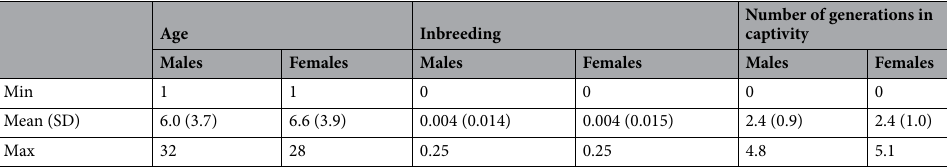
Table 1. Descriptive statistics of the three main explanatory variables used to analyze reproductive parameters within the ECWP’s captive population of houbara. Min . minimum, Max . maximum, SD standard